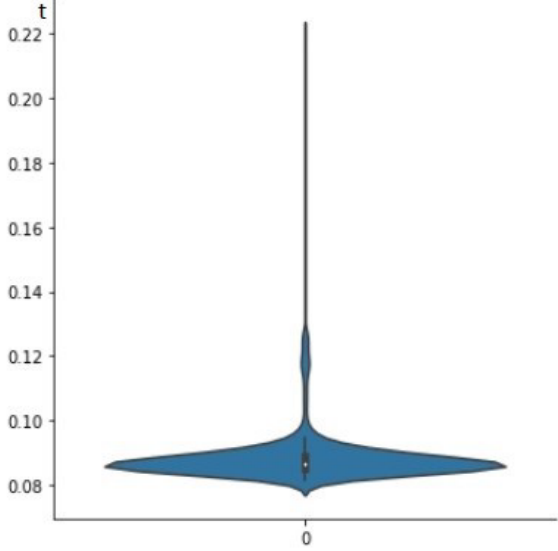
Figure 4. Response time variability in seconds from requests by a local